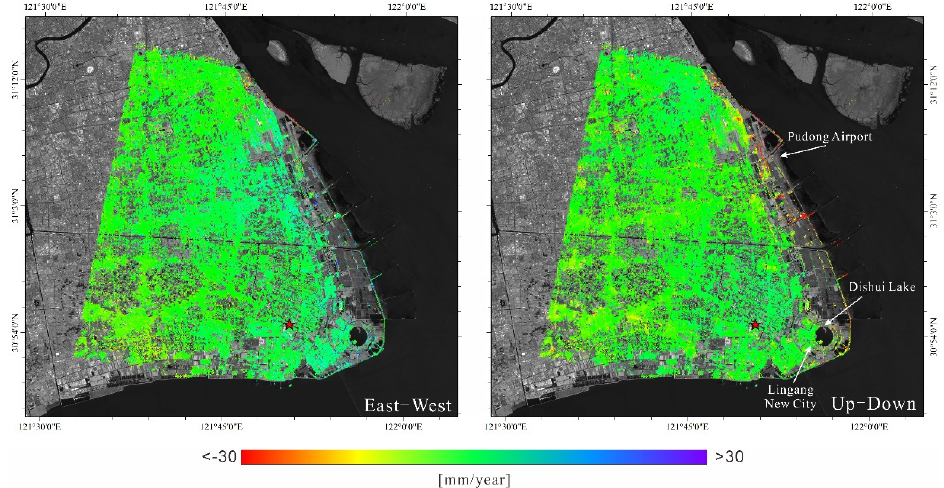
Figure 2. The 2015–2016 two-dimensional mean displacement velocity maps: east–west map ( left ) and up-down map S1-A ( right ) (refer to [26]).